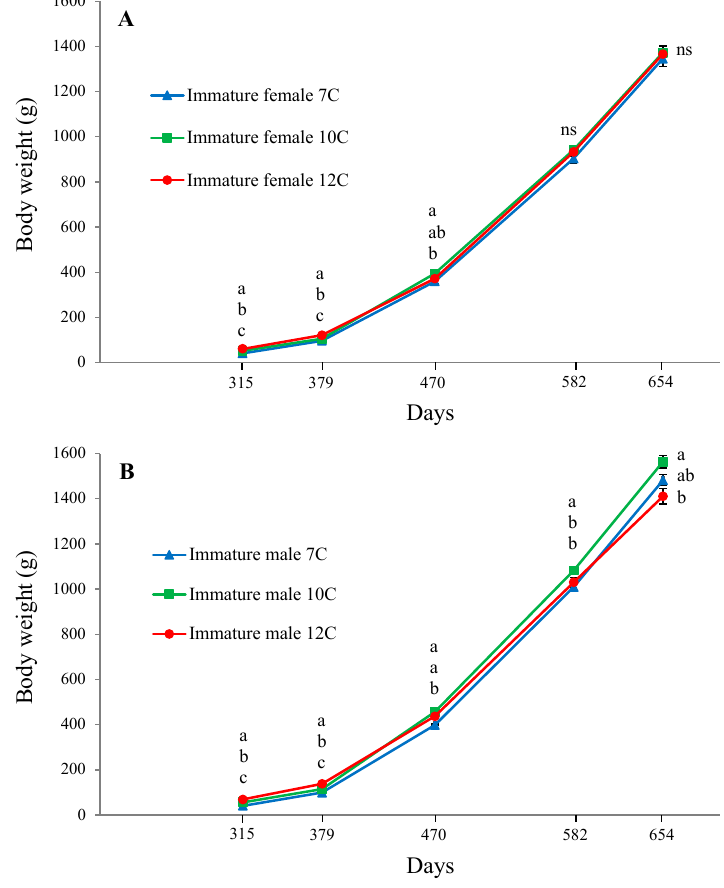
Figure 6. Mean growth in W of immature females ( A ) and males ( B ) during EP2. The 10C and 12C groups were subjected to a decrease in temperature from 10 and 12 °C to 7 °C on day 315, while group 7C remained at 7 °C. In all groups the salinity was increased from 4 to 22 ppt on day 379 after the fish had been transported from Verid to MFRI research station. Different lower-case letters denote significant differences between groups at the 5% level of significance.